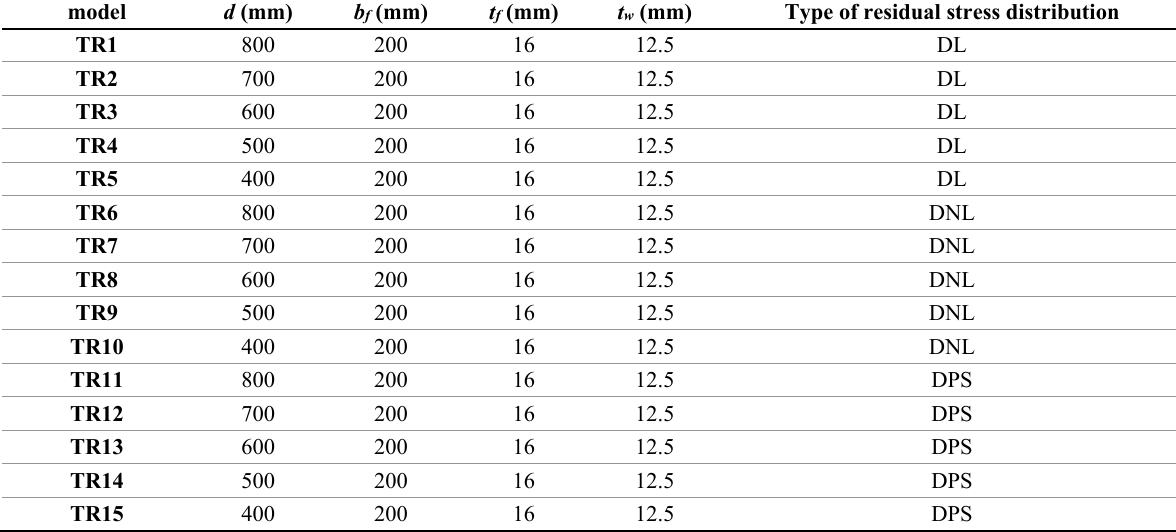
Table 1. Numerical models for residual stress analysis.